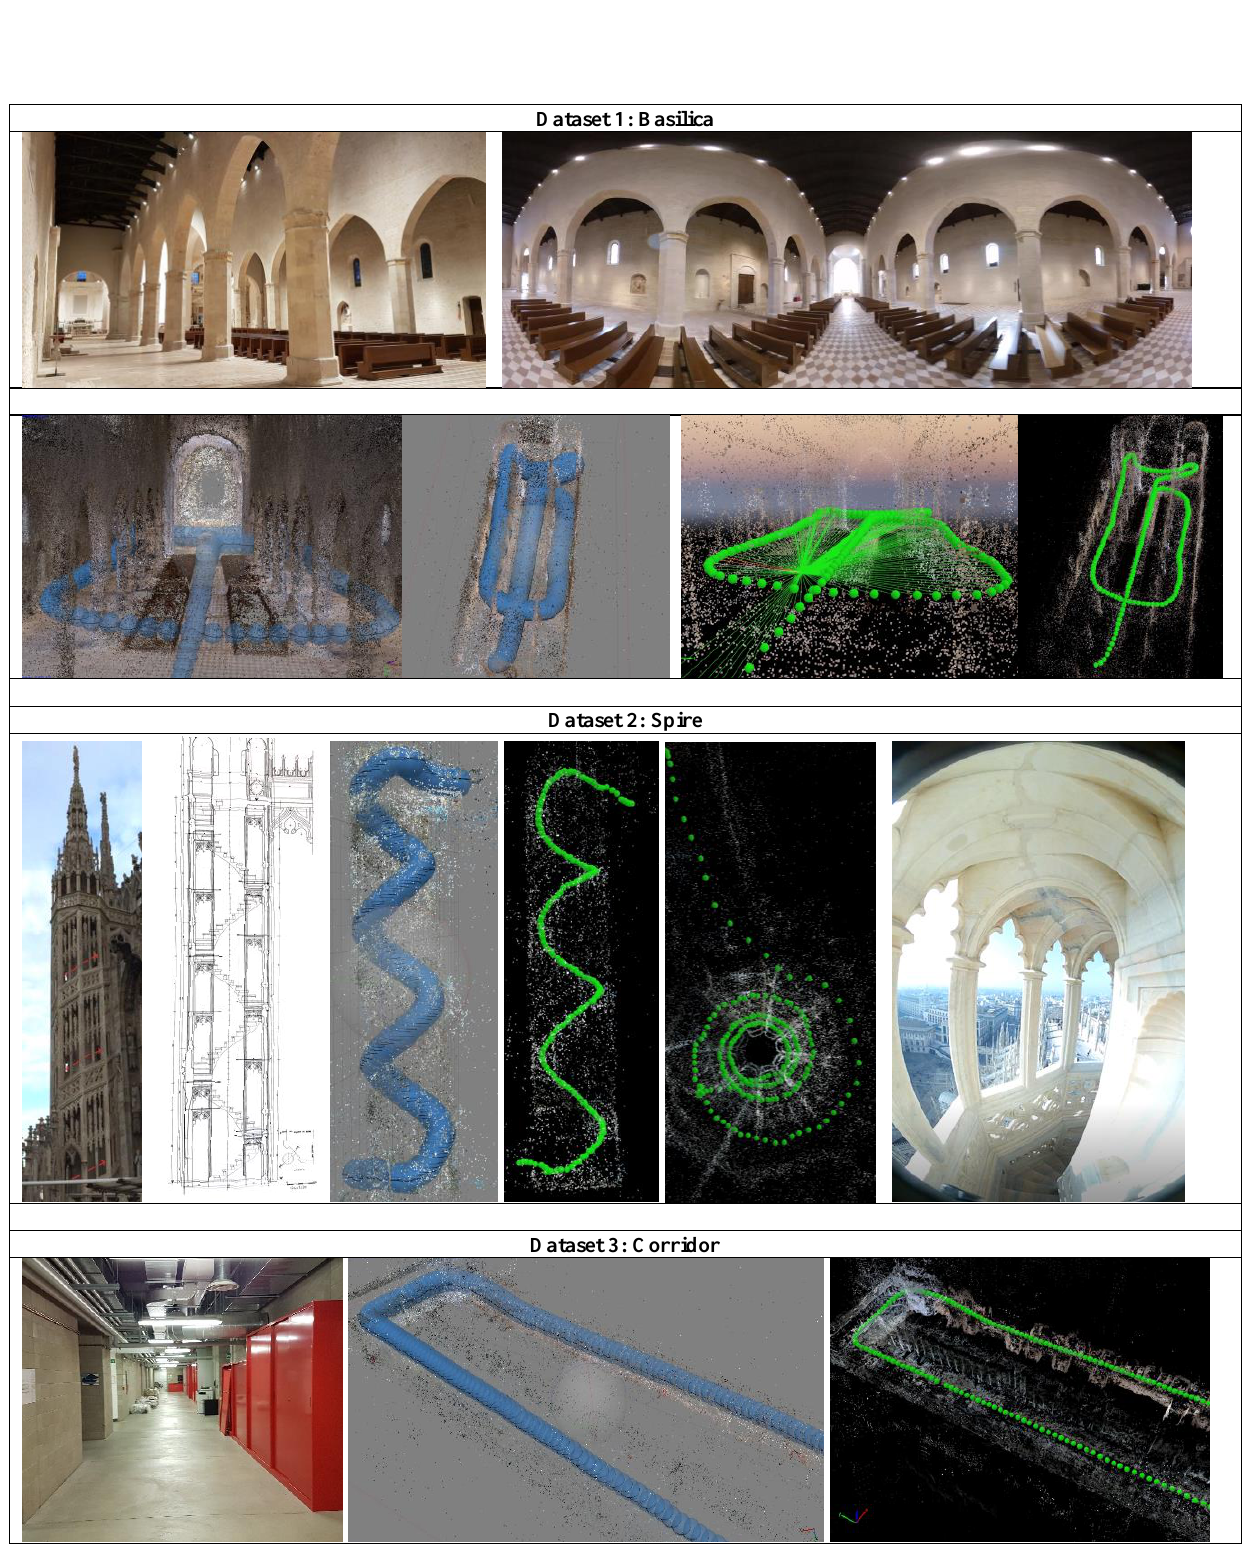
Figure 10. Some projects where the use of a 360° camera could be a better choice than a traditional central perspective